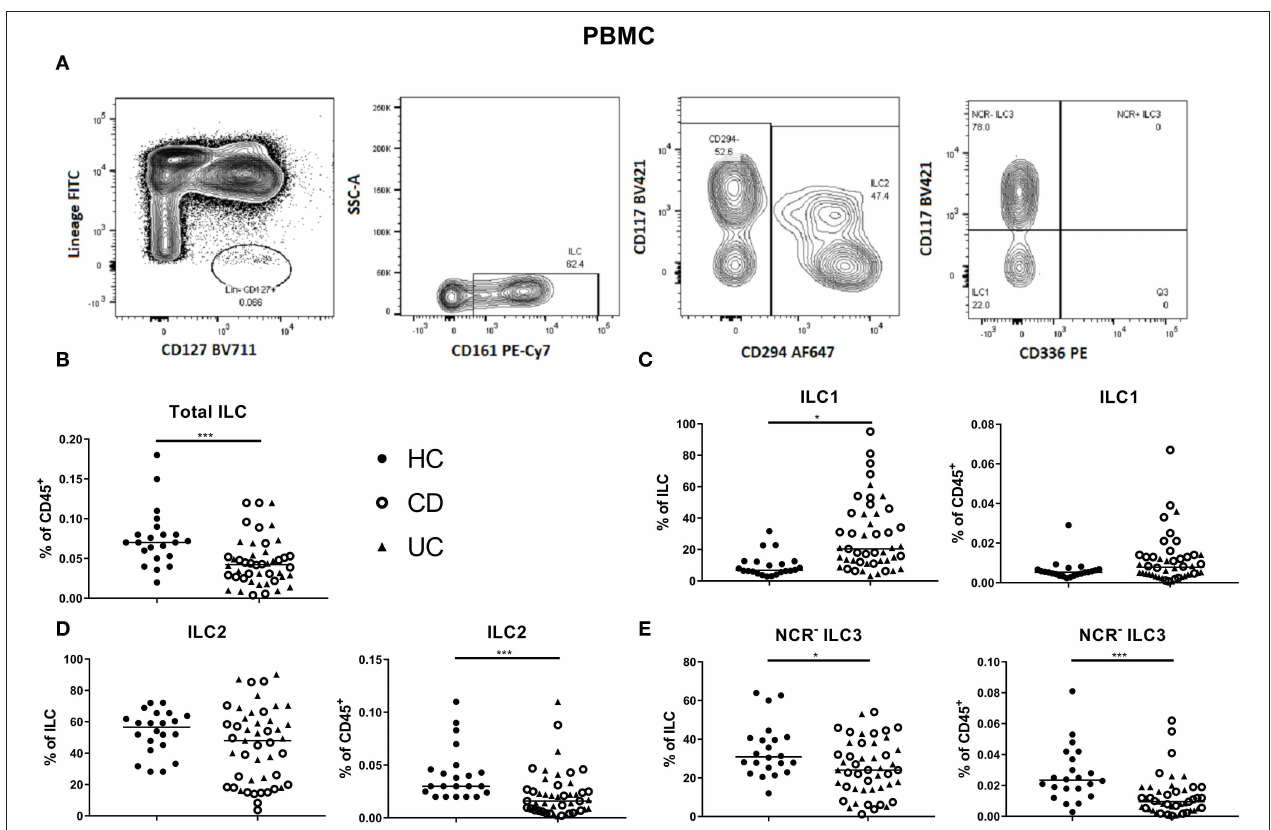
FIGURE 2 | Innate lymphoid cell distribution in the blood of active IBD patients. Gating strategy of innate lymphoid cells (ILCs) among PBMC. Gating was based on FMO and tonsil staining. Representative data in (A) are shown as contour plots (5%) with outliers. Innate lymphoid cells were identified as described in Figure 1 . Contribution of the ILC population to the total CD45 population of PBMC (B) . ILC1 (C) , ILC2 (D) , NCR − ILC3 (E) [each as proportion of total ILC (left) or as percentage of total leukocyte (right) population] for healthy controls ( n = 22) and IBD patients ( n = 45; CD = 24 and UC = 21). Mann–Whitney U testing; * p < 0.05, *** p ≤ 0.001. PBMC, peripheral blood mononuclear cells; FMO, fluorescence minus one; NCR, natural cytotoxic receptor; ILC, innate lymphoid cell; CD, Crohn disease; UC, ulcerative